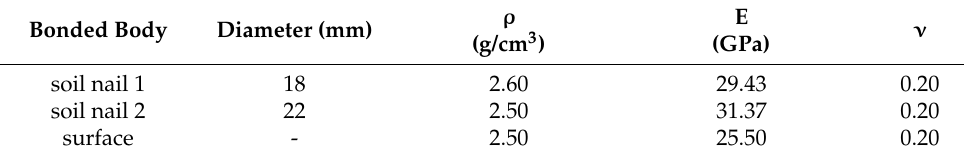
Table 6. The bonded parameters of soil nails and surface. Bonded